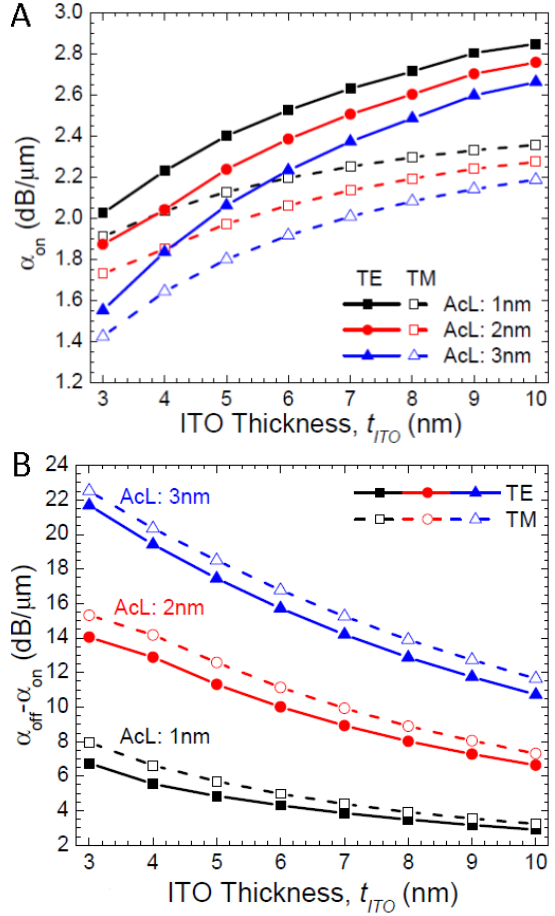
Figure 20: With increase of total thickness of TCO layers, modu- lator’s performance decreases. For instance, for device studied in [141], absorption increases approximately twice (A) and ER de- creases twice (B) with changing thickness from 3 to 10 nm. Copy- right (2014), OSA, from Ref. [141], with permission of the authors. TCO: Transparent conducting oxides